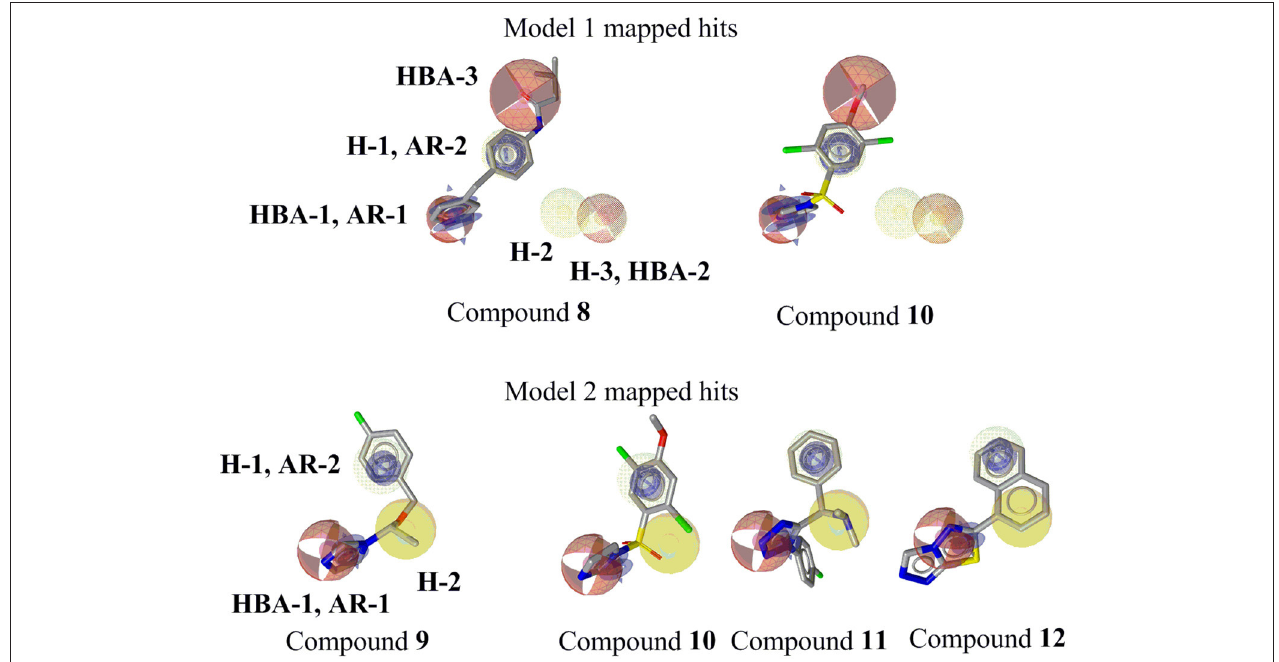
FIGURE 9 | Mapping of novel CYP11B1 and CYP11B2 inhibitors to pharmacophore models. Pharmacophore features are color-coded. Yellow represents hydrophobic, blue denotes AR, and red shows the HBAs. Optional features (dotted style) are not mapped by the virtual hits 8 and 10 .